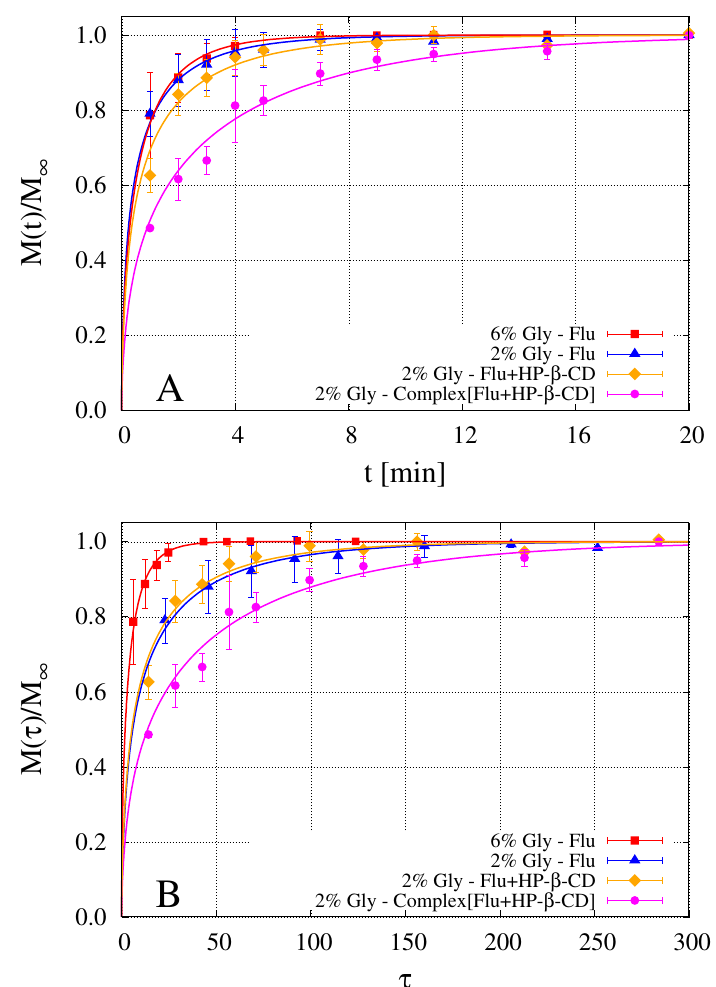
Figure 7. Release data of fluconazole from OTFs in USP II apparatus. Red squares: GG-6%Gly; blue triangles: GG-2%Gly; orange diamonds: GG-2%Gly including the mixture fluconazole/HP- β -CD; magenta circles: GG-2%Gly including the preformed inclusion complex Flu/HP- β -CD. Continuous lines represent model predictions. The corresponding diffusivity values D F and D CD are reported in Table 2. ( A ) M ( t ) / M ∞ vs. time t [min]; ( B ) M ( τ ) / M ∞ vs. rescaled dimensionless time τ = tD o